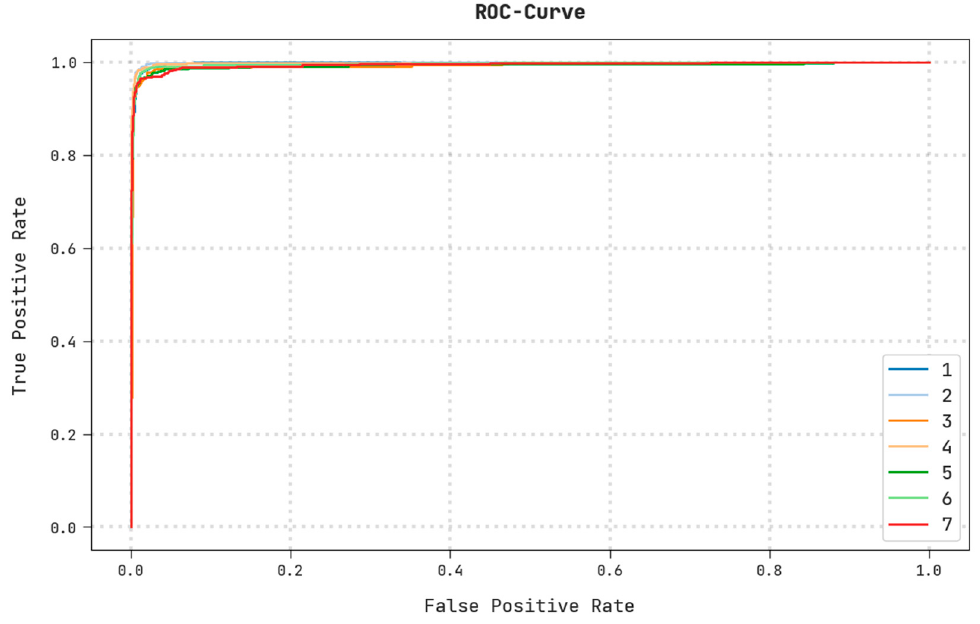
Figure 10. ROC curve analysis of CLBEDC-SND approach.